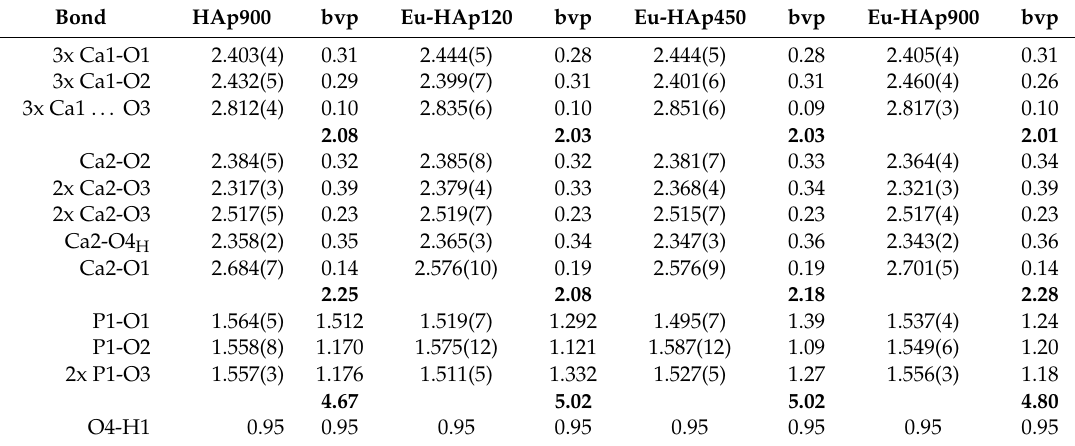
Table 5. Bond distances (Å), and bond valence parameters for HAp samples. Bond valence sums (in bold) are calculated taking into account 9 bvp values for Ca1, 7 bvp values for Ca2, and 4 bvp values for P1.